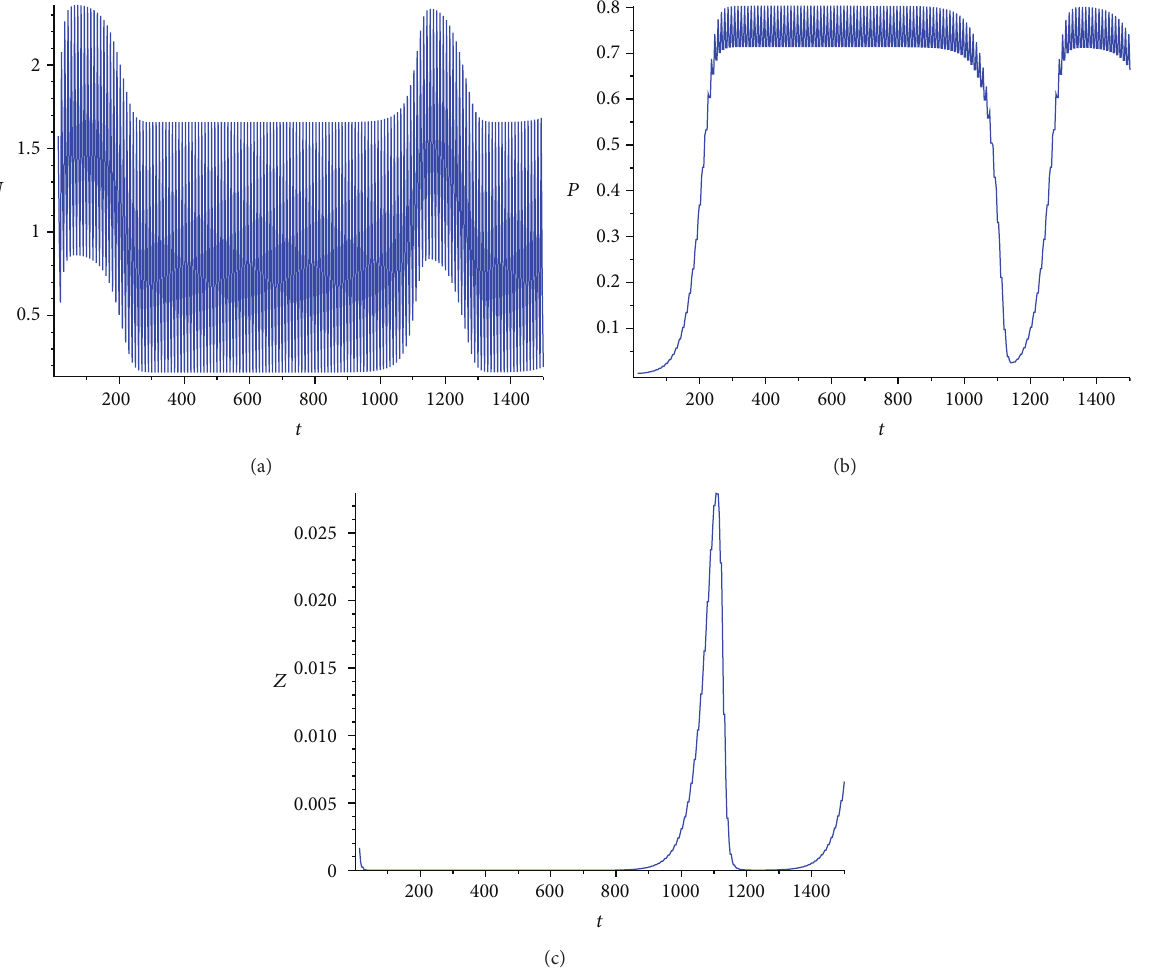
Figure 6: Another phenomenon of system (22). (a), (b), and (c) are time series of nutrient, phytoplankton, and zooplankton, respectively, where 𝜆 = 1.7